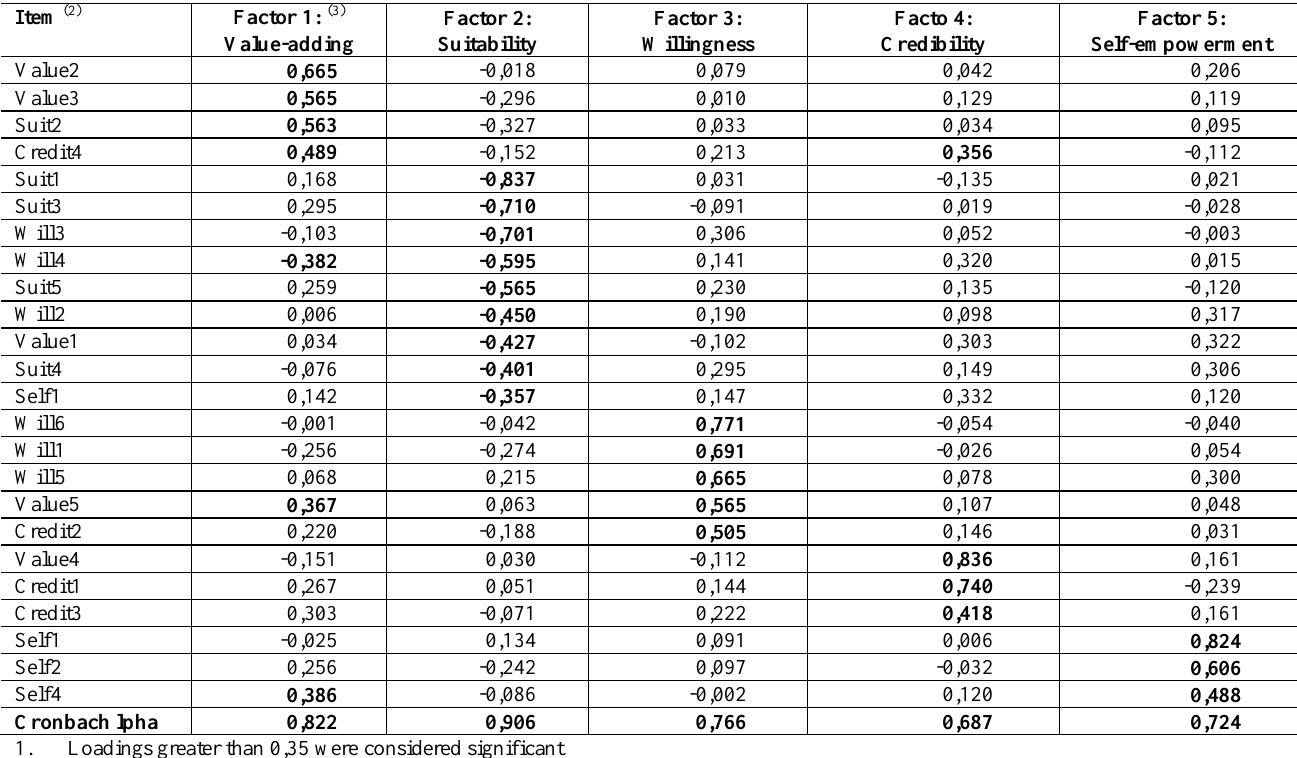
Table 2: Pattern matrix of Oblimin rotated-principal component factor analysis (1)